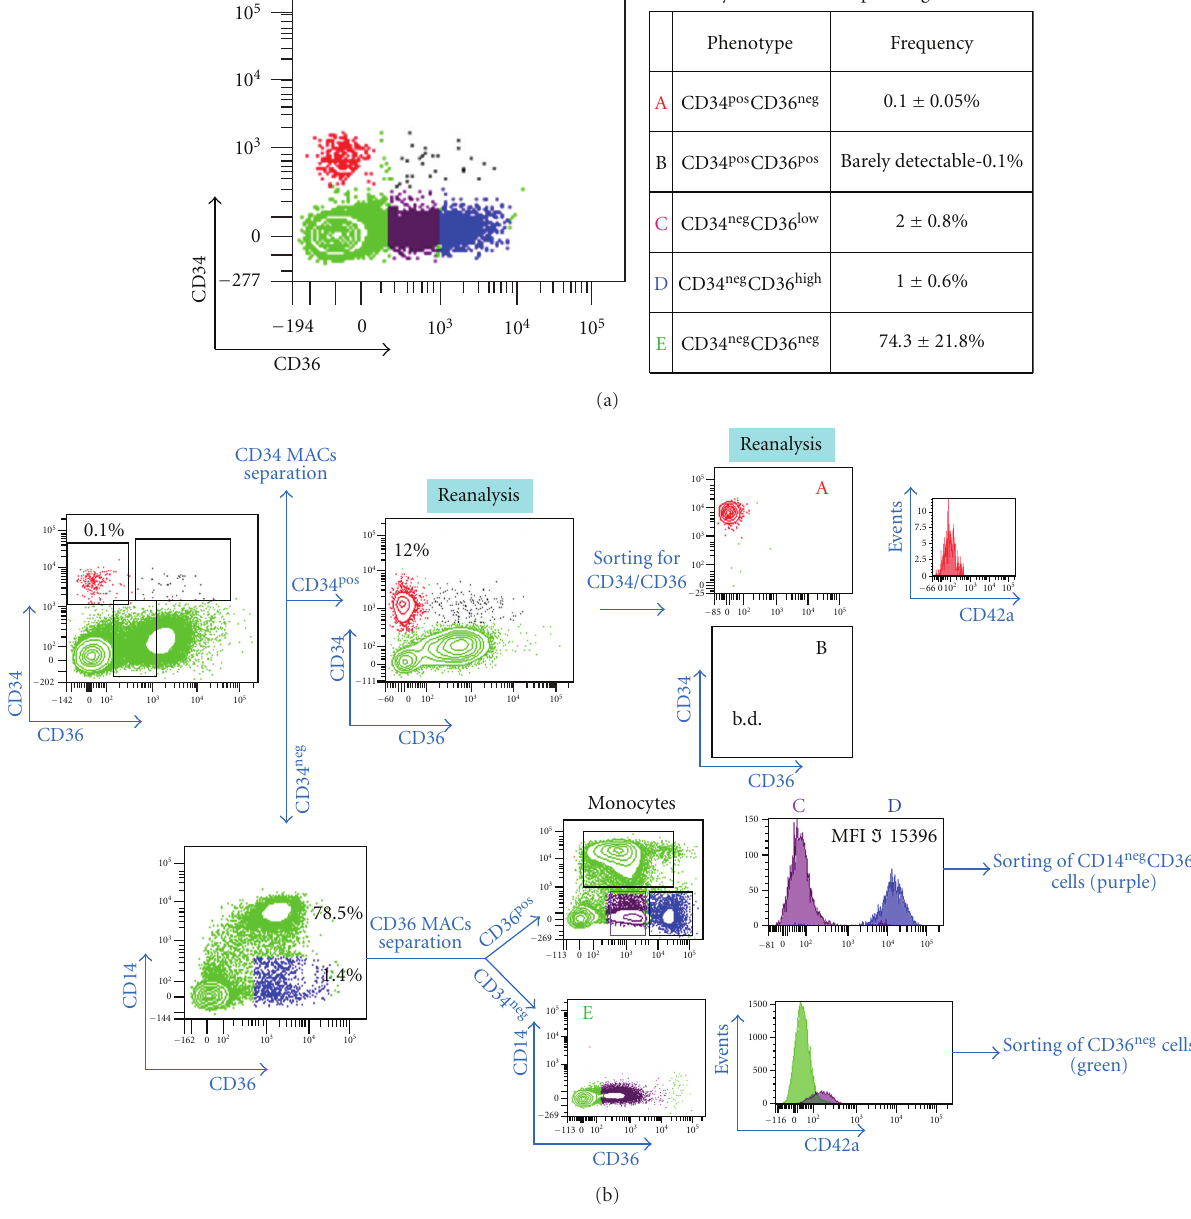
Figure 1: CD36/CD34 expression profiling of AB MNC. ( a) Representative coulter plot analyses for CD36/CD34 expression of MNC from a representative AB and summary of the frequency of the di ff erent populations identified by this analyses. CD36/CD34 profiling identified five populations: CD34 pos CD36 neg cells (population A, red), CD34 pos CD36 pos cells (population B, black), and CD34 neg CD36 neg cells (population E, green). A fourth CD34 neg CD36 pos population contained numerous CD14 pos cells which are represented by monocytes (see Figure 1(b)). Exclusion of these CD14 pos cells from the analyses revealed two CD34 neg / CD36 pos populations which express CD36 al low (CD34 neg CD36 pos , population C, purple) and high (CD34 neg CD36 high cells, population D, blue) levels, respectively. The table on the right summarizes the mean frequency ( ± SD) of each population among MNC obtained from 3 di ff erent donors. All the results presented in this figure and in Figure 2(a) are presented with the same color code. (b) Prospective isolation of AB MNC on the basis of CD34/CD36 expression. MNC were first divided in two populations enriched or deprived of CD34 pos cells by CD34-coated magnetic bead adsorption. The CD34 pos population was further purified and divided into CD36 neg and CD36 pos cells by sorting. The CD34 beads flow-through fraction (enriched for CD34 neg cells) was further divided into CD36 pos and CD36 neg cells by magnetic bead isolation. The cells eluted from the beads were purified by sorting on the basis of lack of expression of CD14 and low level of CD36 expression (population C, purple). The CD14 neg CD36 high cells (population D, blue) were not isolated because expressed high levels of the megakaryocytic marker CD42a. Finally, the CD36 beads flow-through fraction was enriched for CD36 neg cells by sorting. These CD36 neg cells were also CD34 neg upon reanalyses (not shown). Whenever feasible, the prospectively isolated cells were reanalyzed for purity. Results are representative of those obtained in 3 independent